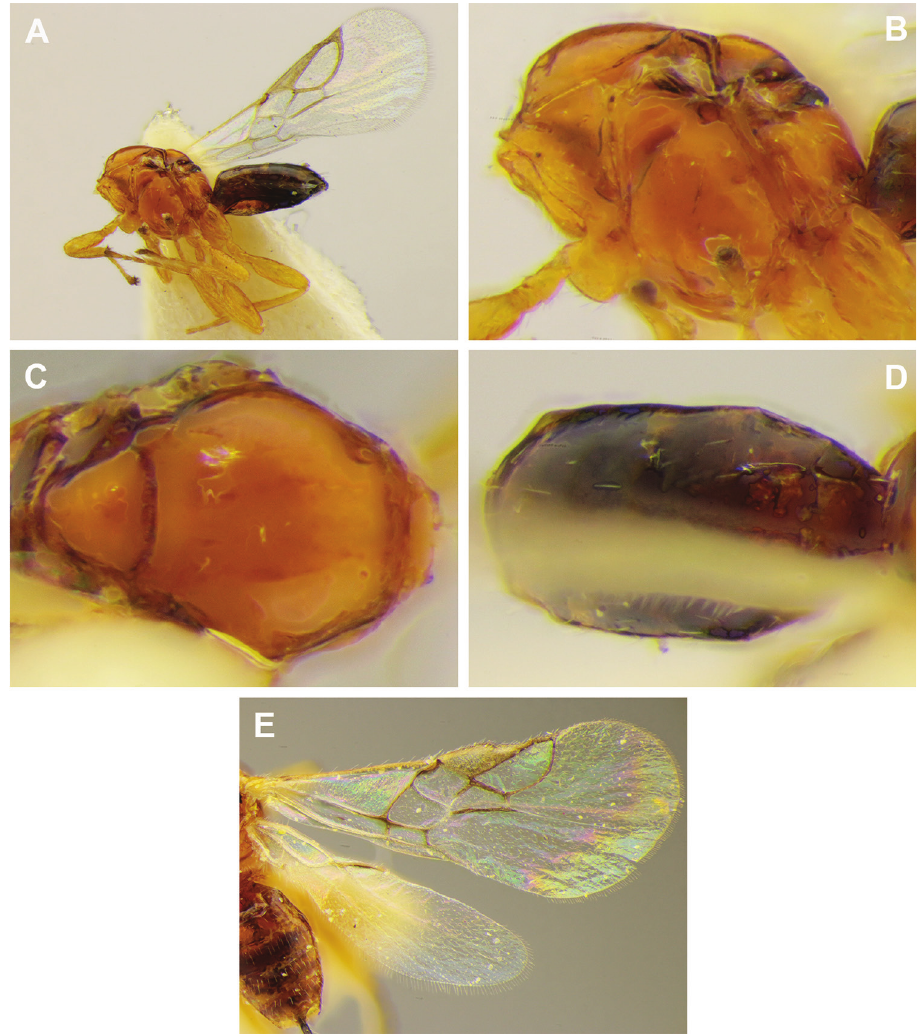
Figure 7. Hoplocrotaphus pospelovi Telenga, 1950 ( A–D lectotype: male E specimen from Turkmenistan, female) A Habitus, lateral view B Mesosoma, lateral view C Mesoscutum, dorsal view D Metasoma, dorsal view E Fore and hind wings. as high; inner margins of eyes subparallel. Clypeus 4.6 times as wide as high, slightly curved ventrally. Temple in lower half without prominence. Occipital carina ventrally widely separated from hypostomal carinae. Mandible basally with distinct ventral lobe. Antenna 17- segmented. Scape 1.5 times as long as pedicel. First flagellar segment 3.3 times as long as its apical width, 1.2 times as long as second segment; second segment 2.8 times; third to eighth segments 2.5–2.6 times; ninth to 14 th 2.3 times, and 15 th (apical) segment 3.3 times as long as their maximum width